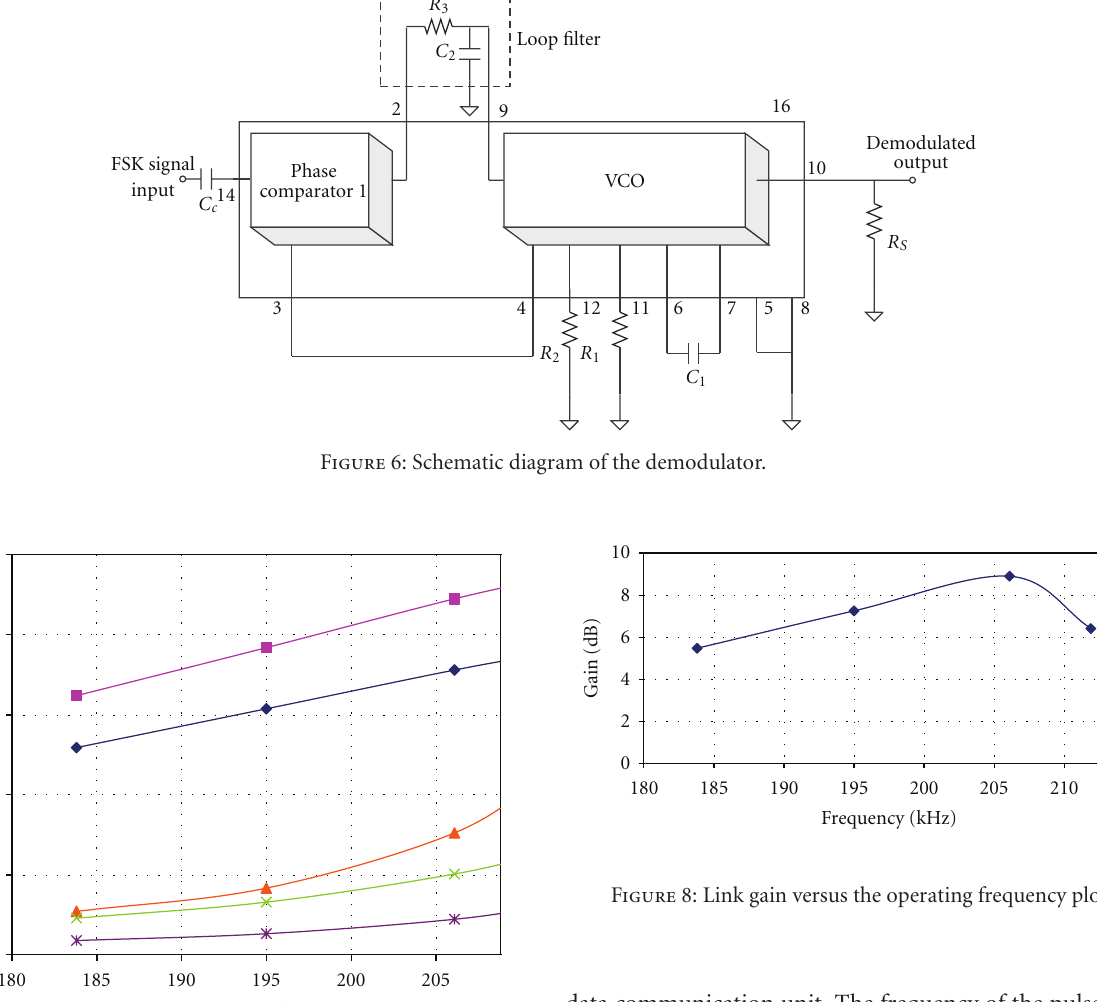
data communication unit. The frequency of the pulse signal conveys the information of the sensor current